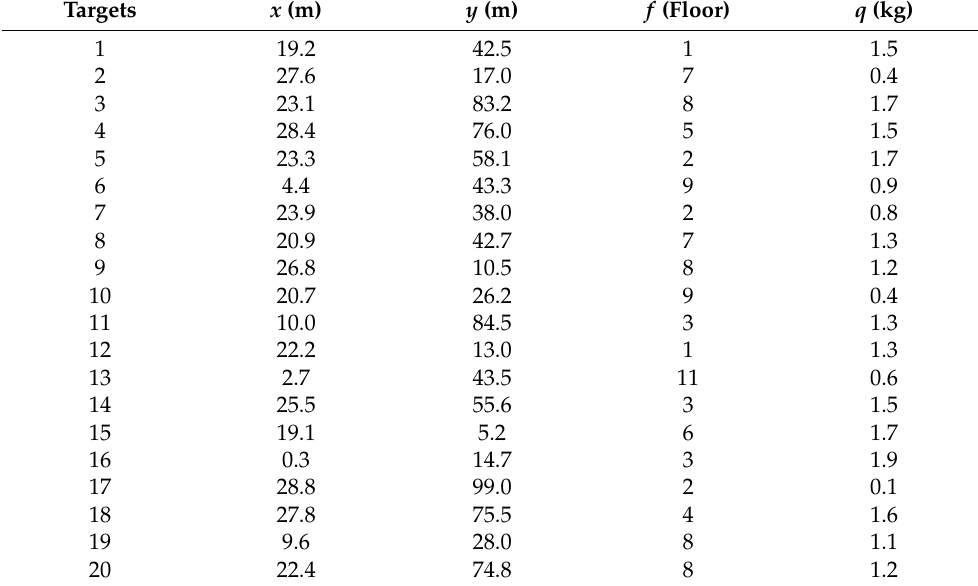
Table 4. Parameters of